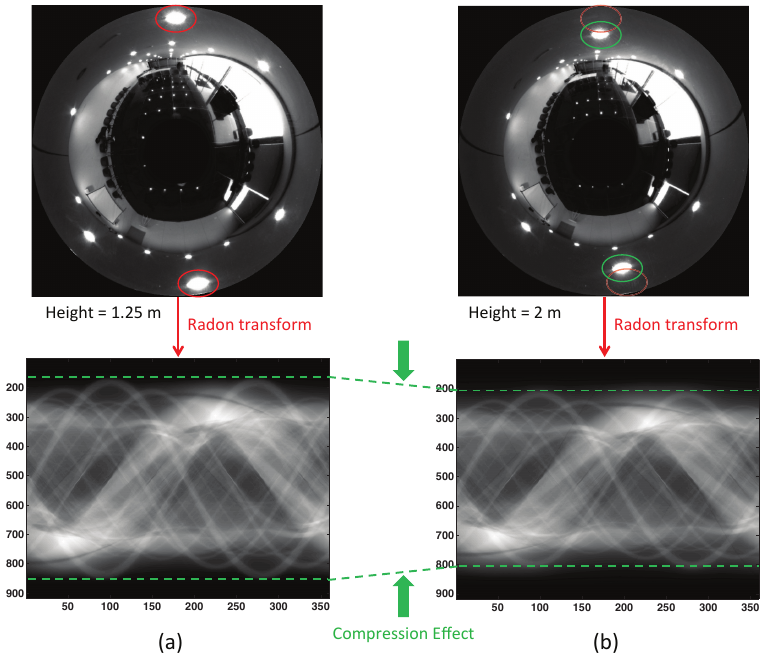
Figure 3. Example of the Radon transform compression effect. The figure shows the omnidirectional image and its Radon transform captured at ( a ) h = 1.25 m and ( b ) h = 2 m. Comparing both Radon transforms, the second one presents a compression effect with respect to the first